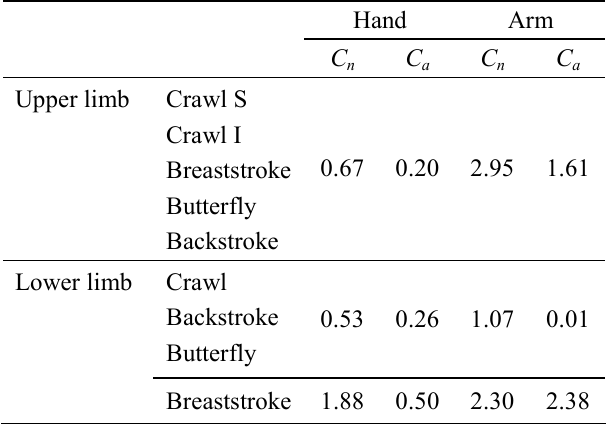
Unified fluid force